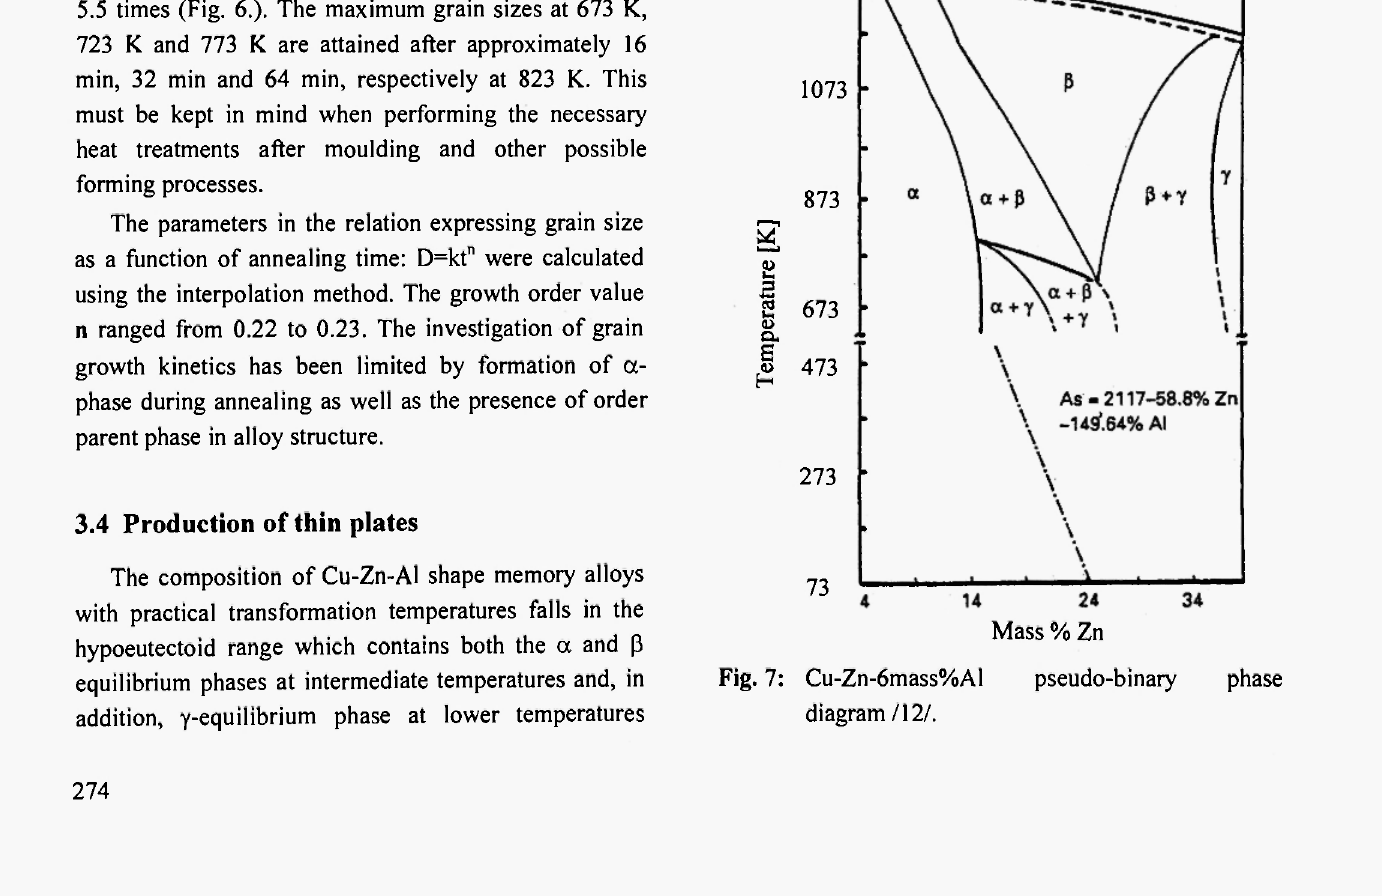
Mass % Fig. 7: Cu-Zn-6mass%Al pseudo-binary phase diagram /12/.